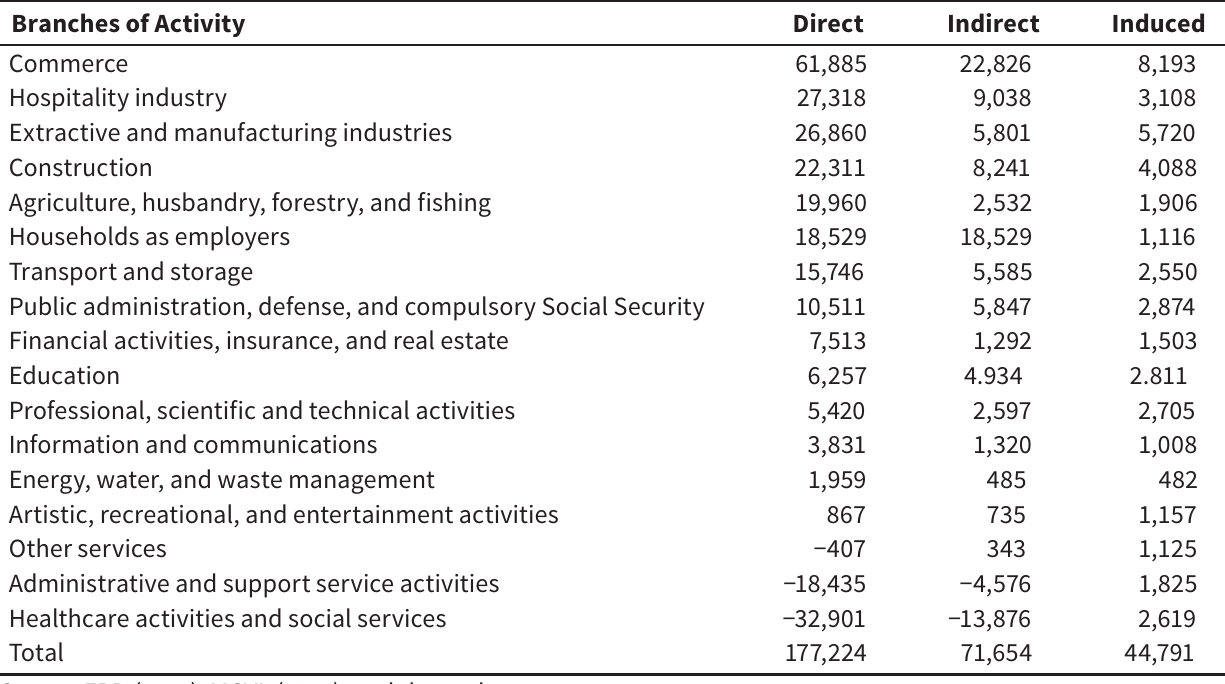
Impact on sectoral employment of the elimination of the labor gap for persons with disabilities,